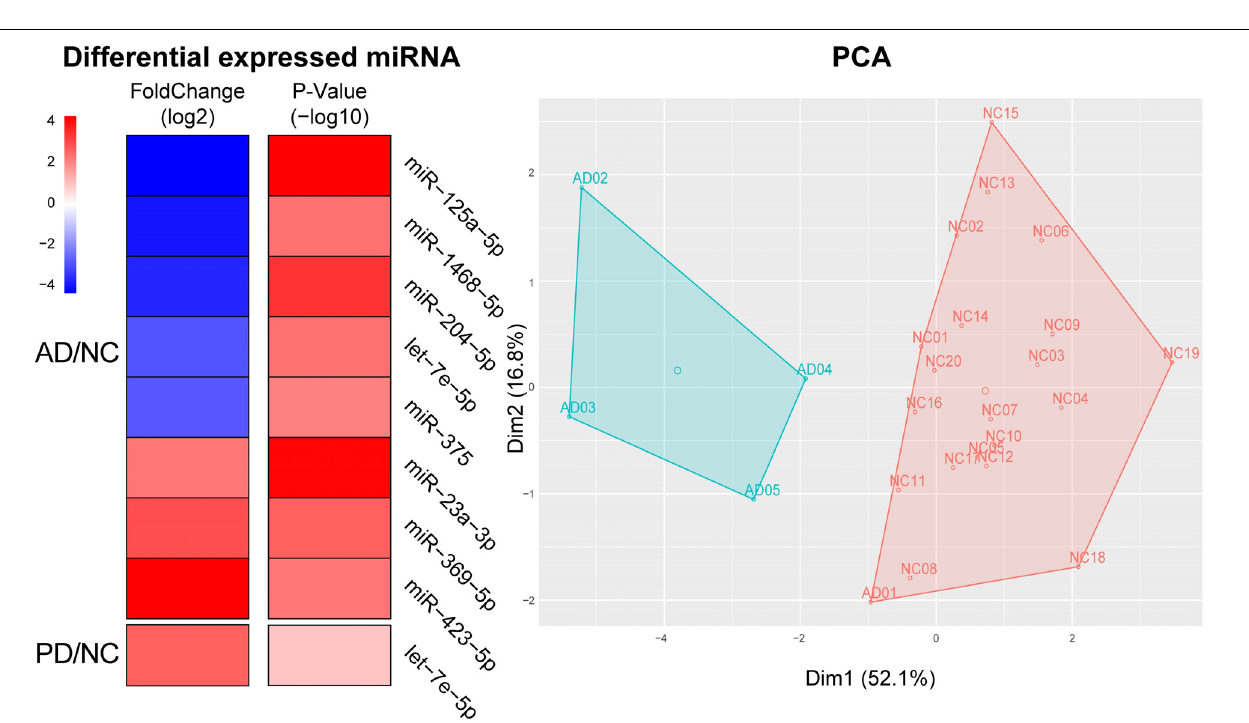
FIGURE 3 | Using significantly altered expression of miRNAs to distinguish AD from NC. Left, Heatmap of significant altered levels of miRNA expression in AD and PD samples. DESeq2 was used to identify significantly up-/down-expressed levels of miRNAs. Fold change was presented by log 2 and p -value was presented by log 10 . PCA and k-means based clustering was performed to distinguish AD samples from NC samples by using significantly expressed levels of miRNAs.